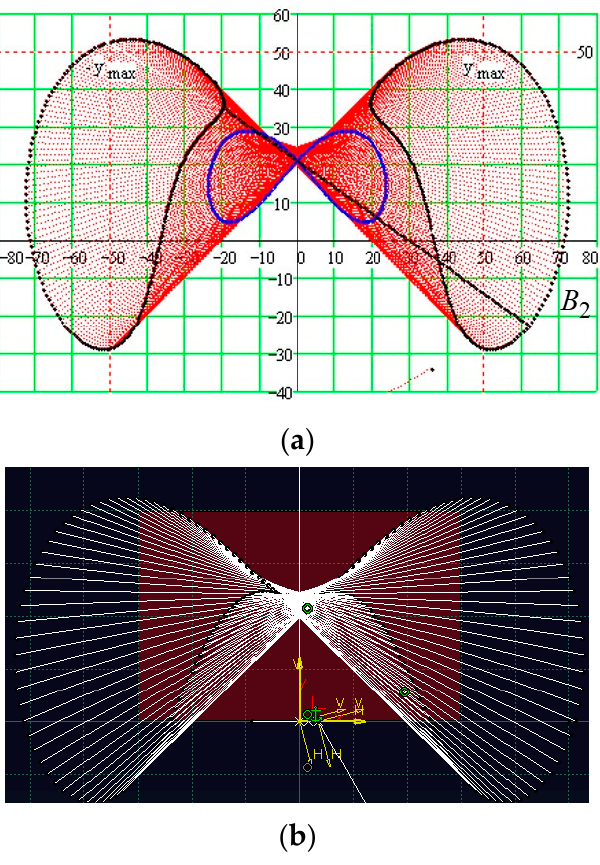
Figure 8. The geometrical loci of a straight line (B 2 ) attached to element 2 with respect to element 1: ( a ) analytical and ( b ) numerical results. The successive positions (in the plane of plate 2) of a line segment fixed to element 1 are presented in Figure 9. Gridlines are evidenced on both images (for analytical results from Mathcad and numerical results from CATIA), and these permit the precise identification of the coordinates of any point from the figures. The concordance between the coordinates of similar points from the two figures is a quantitative procedure for the validation of the analytical results. Figure 9 exemplifies a numerical comparison of coordinates of similar